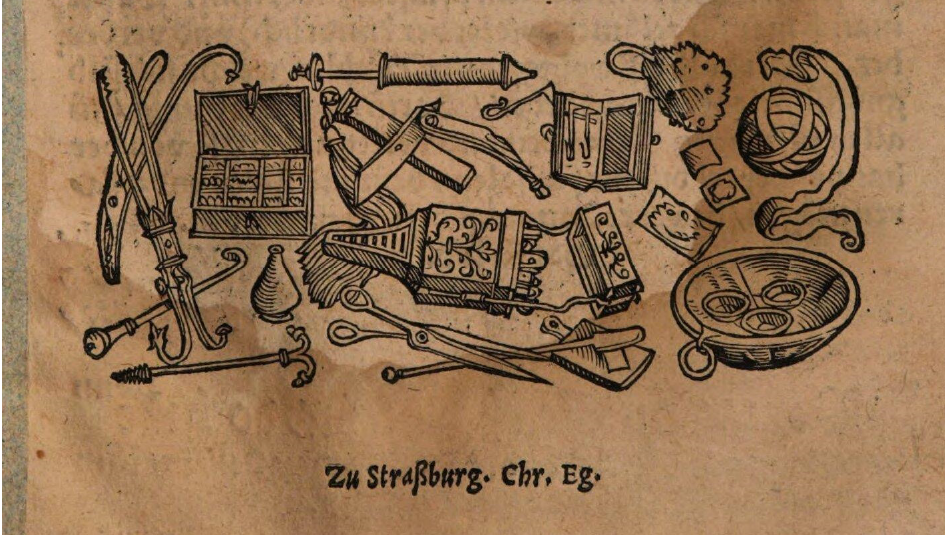
Figure 5. Precision surgical instruments including an instrument case (centre) with the lid detached. Johannes de Ketham, Wurdartznei: Zu allen Gebrechen des Gantzen Liebs (Strasbourg: Eg[enolff], 1530), frontispiece. Munich, Bayerische Staatsbibliothek—Res/4 Chir.